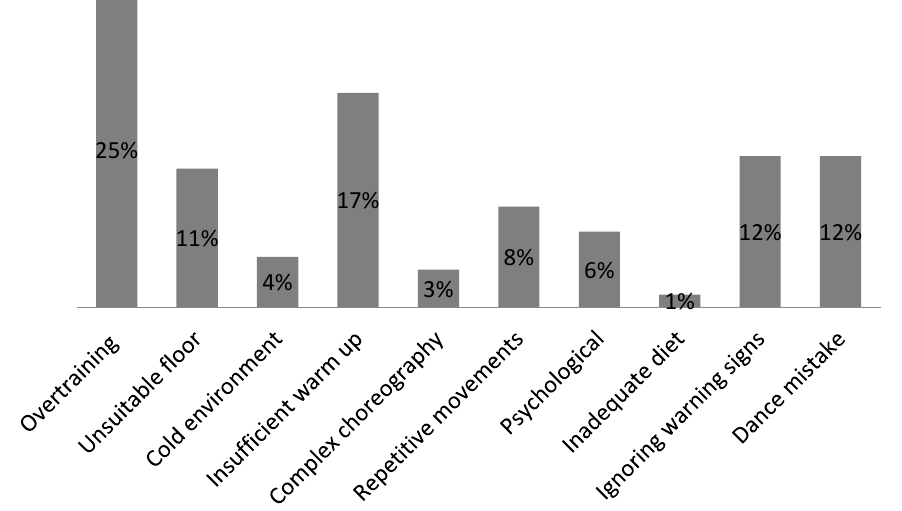
Figure 3. Percentage of perceived causes of injuries in sport-dance.